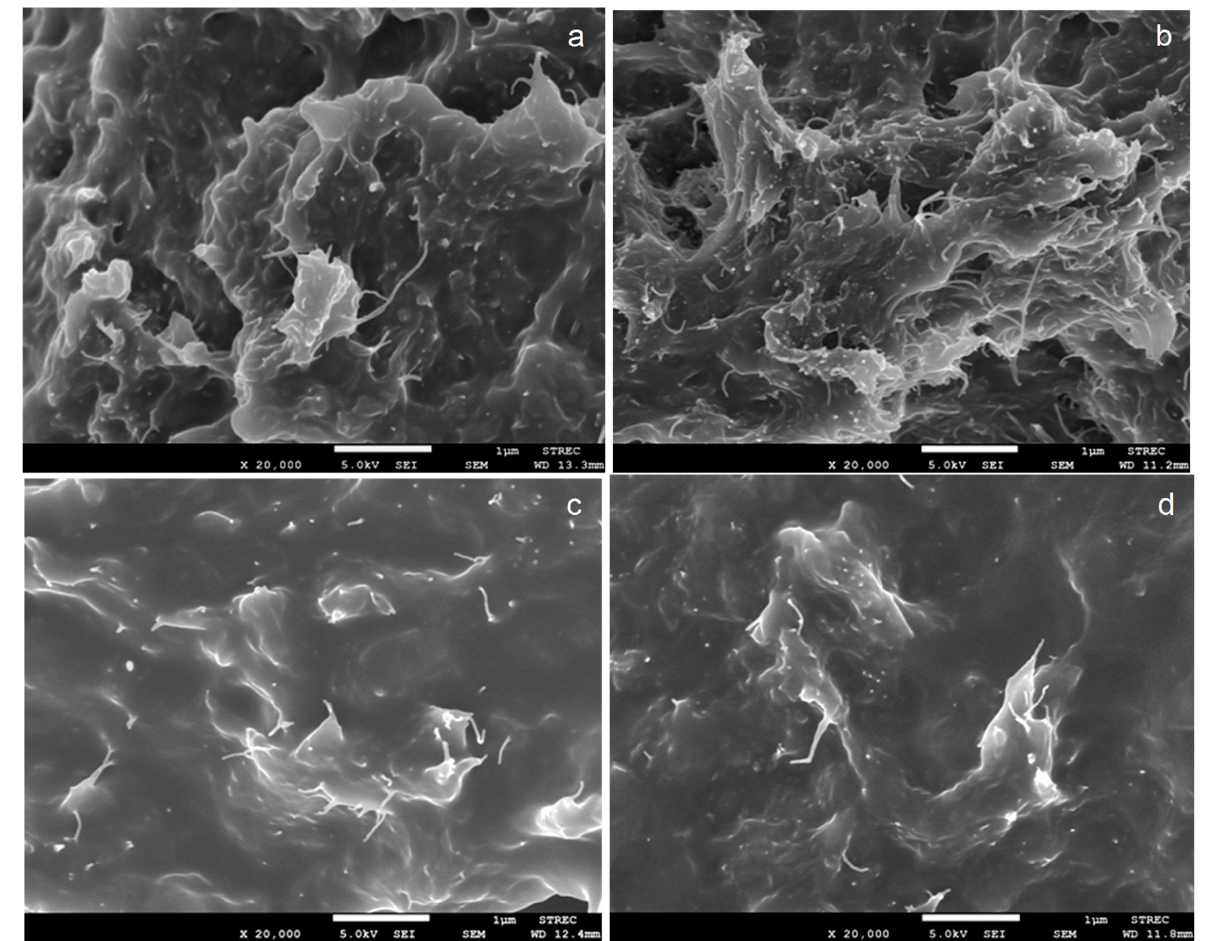
Figure 6 . FESEM images of PU - Ether / MWCNT nanocomposites unannealed ( a ) and annealed at 80 Figure 6. FESEM images of PU-Ether/MWCNT nanocomposites unannealed ( a ) and annealed at °C ( b ) , 100 °C ( c ) and 120 °C ( d ) for 6 h . 80 ◦ C ( b ), 100 ◦ C ( c ) and 120 ◦ C ( d ) for 6